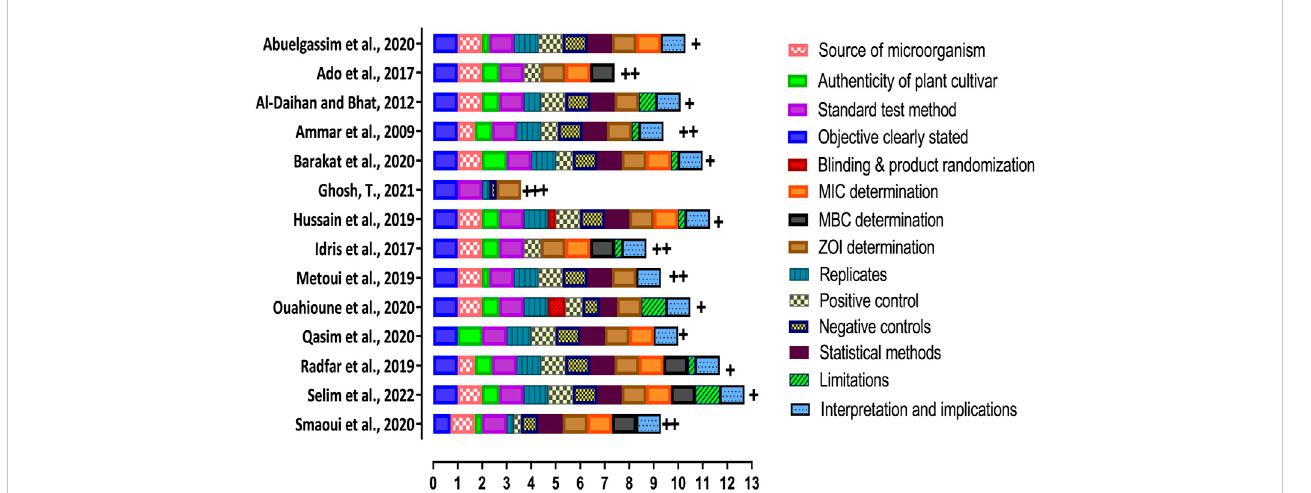
FIGURE 2 Risk of bias (ROB) assessment. Articles were assessed based on whether the records have reported. the source of microorganism, authenticity of plant cultivar, standard test method usage, clear statement of objective of the study, blinding and product randomization, MIC determined, MBC determined, ZOI determination, replicate analyses was performed, positive and negative control usage, statistical methods used for data analyses, identi fi edlimitations of their study and providing the interpretation and implications of the observed outcomes. Each of the quality assessment criteria is identi fi ed as a different coloured box. The size of the box is determined by the mean of the assigned scores given by the three authors for that parameter. After rounding the mean totalscorestonearestwholenumber,theROBoftheselectedstudieswascalculatedasfollows:Reporting0 – 5items-highROB(score+++);Reportingsixto nine items - medium ROB (score ++); Reporting 10 – 14 items - low ROB (score